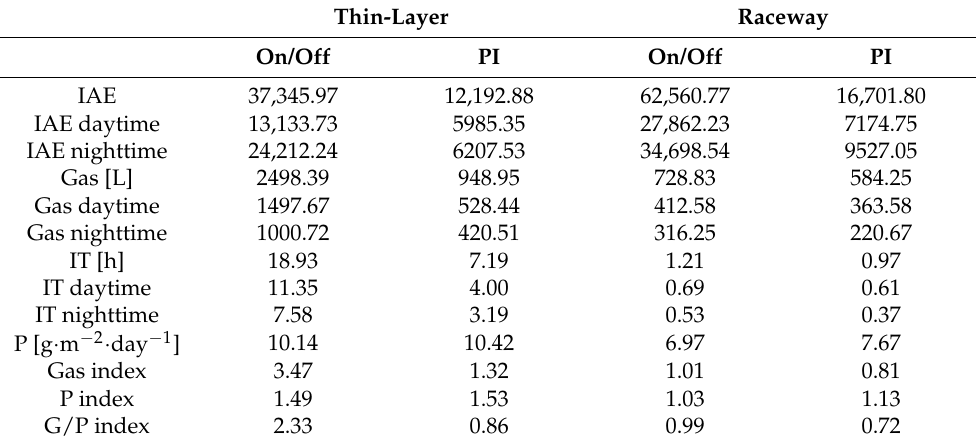
Table 4. Performance measurements of control On/Off and PID operated